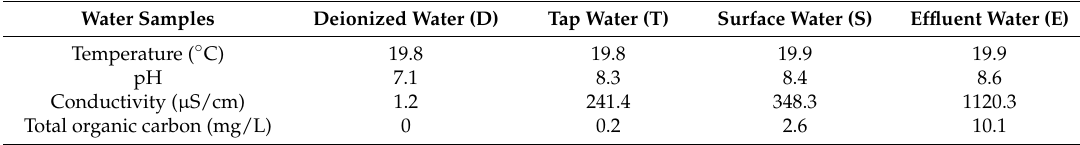
Table 2. The main properties of the water